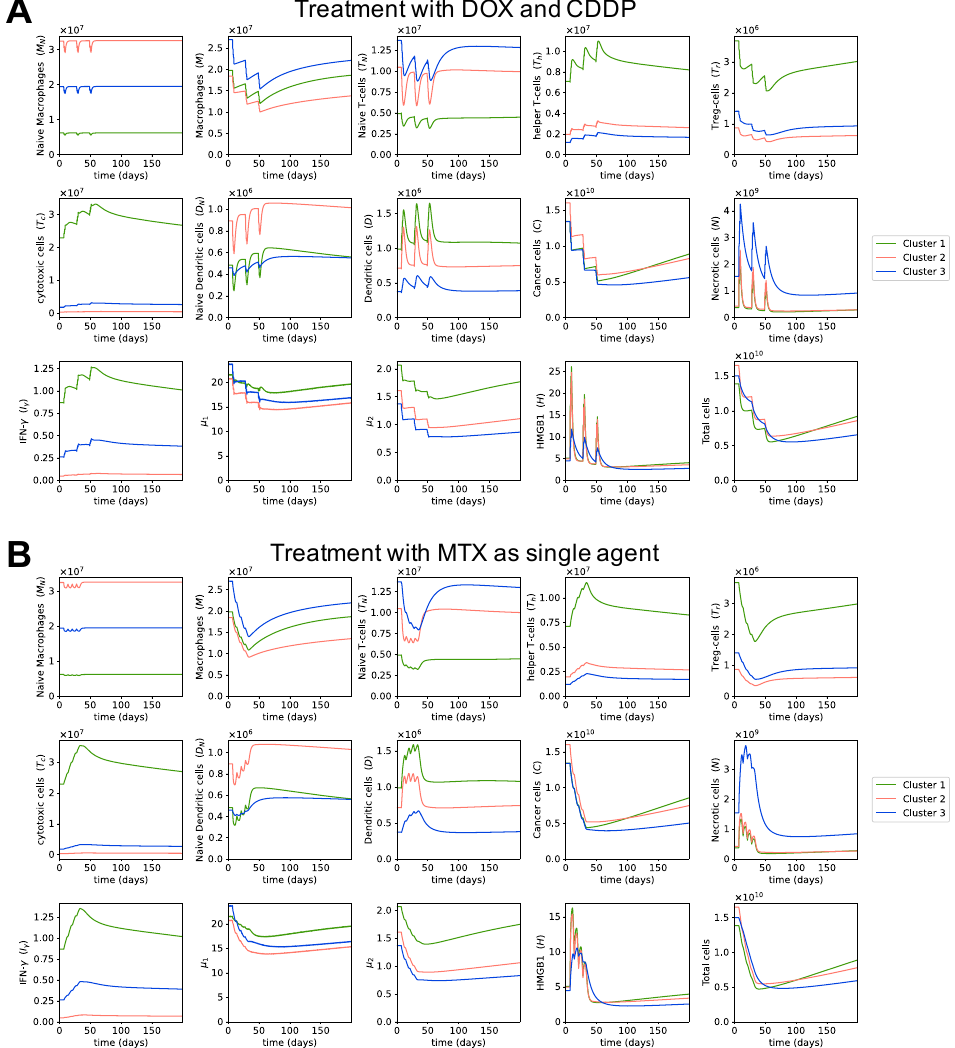
Figure 7. Dynamics with different treatment regimens. Sub-figure ( A ) shows the dynamics of cells and cytokines in osteosarcoma microenvironment in response to the combination of doxoru- bicin and cisplatin. Sub-figure ( B ) shows the dynamics of cells and cytokines in the osteosarcoma microenvironment in response to a high dose of methotrexate as a single